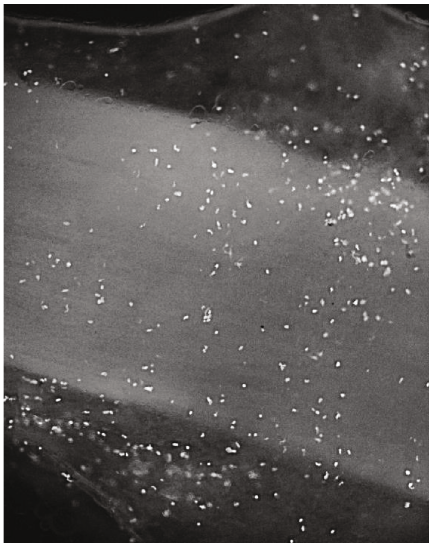
Figure 1: DAPI staining of longitudinal section of a sciatic nerve allograft. Magni fi cation × 100.